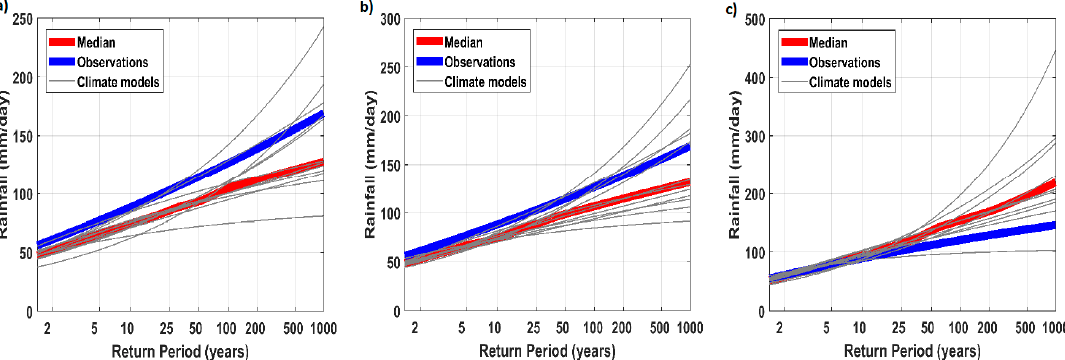
Figure 7. Annual maximum daily precipitation frequency curves in Riaño catchment. Red lines represent the median of the 12 climate models considered. ( a ) Raw precipitation supplied by climate models; ( b ) linear bias correction; ( c ) polynomial bias correction.